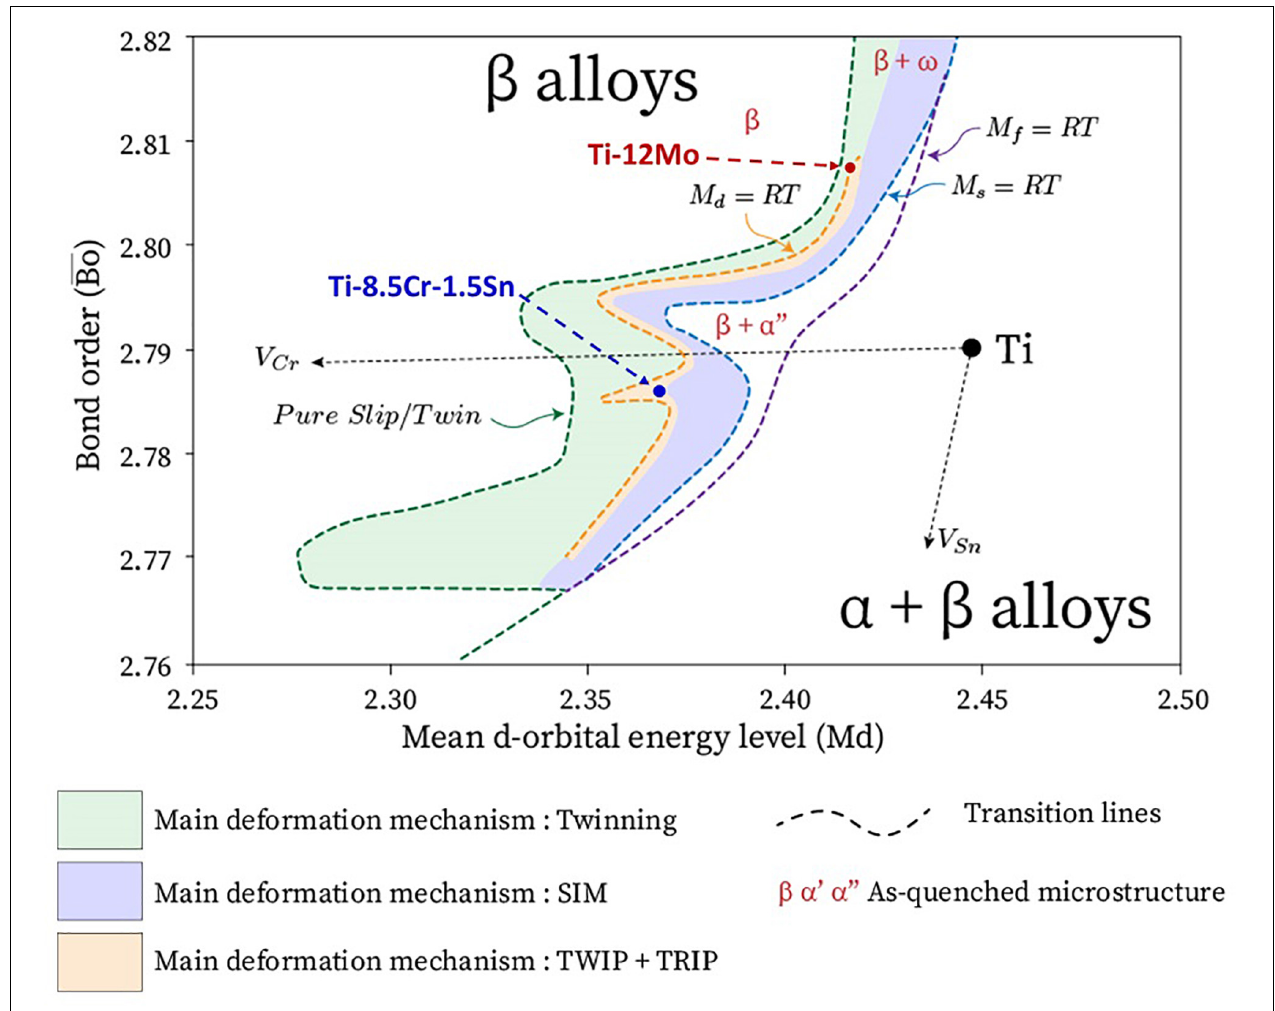
FIGURE 2 | Location of the Ti–12Mo and the Ti–8.5Cr–1.5Sn alloys (in wt%) in Bo − Md